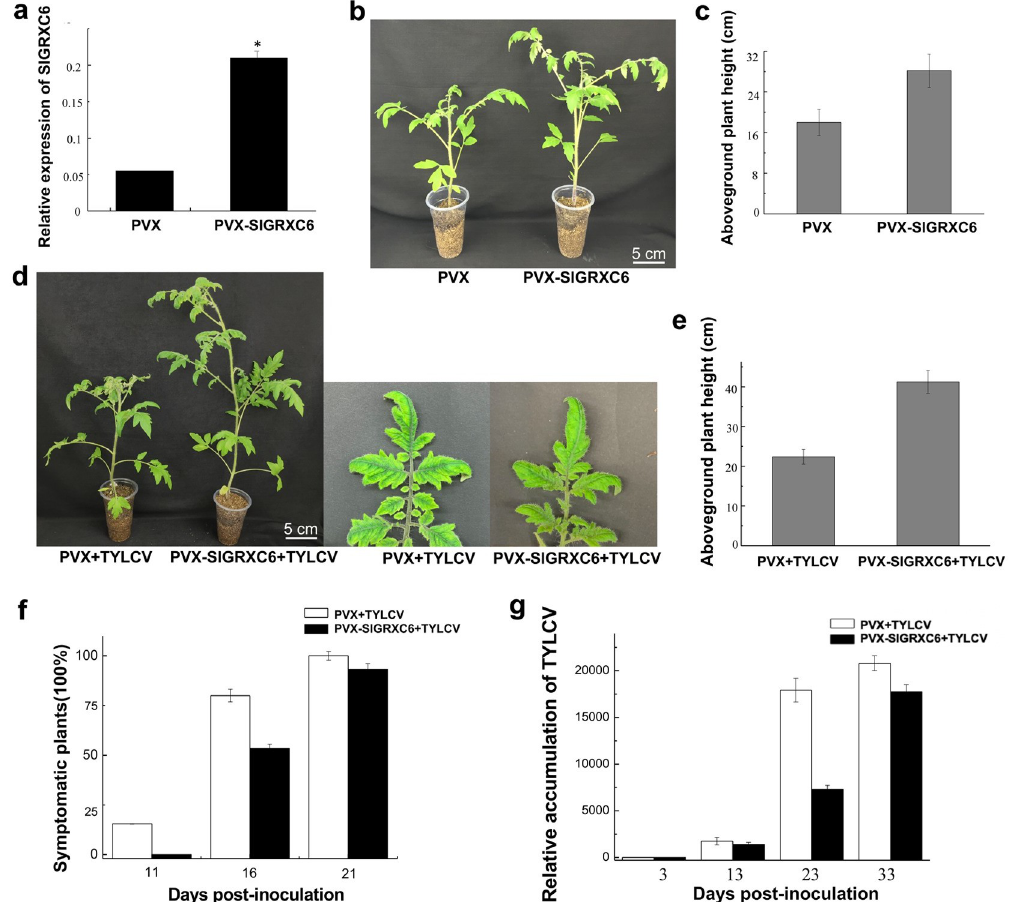
Fig 2. The overexpression of SlGRXC6 inhibits TYLCV infection in tomato plants. (a) The relative levels of SlGRXC6 transcripts in plants, which were treated with PVX or PVX-SlGRXC6, were determined by qRT-PCR at 8 dpai. Total RNA was extracted from newly emerged systemic leaves. Values represent the mean relative to the mock-treated plants (n = 3 biological replicates) and normalized with SlActin as an internal reference. Data are means ± SD (n = 3). Asterisk indicates a statistically significant difference ( � p < 0.05) according to Student’s t-test. (b) Tomato plants treated with PVX or PVX-SlGRXC6. Plants and newly emerged systemic leaves were photographed at 8 dpai. Bar: 5 cm. (c) The aboveground plant heights of PVX or PVX-SlGRXC6 plants were measured at 16 dpai. (d) Tomato plants treated with PVX and PVX-SlGRXC6 responded differently to TYLCV infection. Plants and newly emerged leaves were photographed 13 days after TYLCV inoculation. Bar: 5 cm. (e) The plant height of TYLCV-inoculated tomato plants treated with PVX or PVX-SlGRXC6. Plants were measured 13 days after TYLCV inoculation. (f) The time course of TYLCV infection in PVX control or PVX-SlGRXC6 plants. Values represent percentages of systemically infected plants at the indicated time points. In each experiment, 15 plants were inoculated and three independent repeats were performed. Experiments were repeated three times with similar results. (g) The viral genomic DNA accumulation in systemic leaves as measured by qPCR. Accumulated levels of viral genomic DNA were tested in PVX control or PVX-SlGRXC6 tomato plants infected with TYLCV at 3, 13, 23, and 33 dpi as in a. Data are means ± SD (n = 3). Experiments were repeated three times with similar